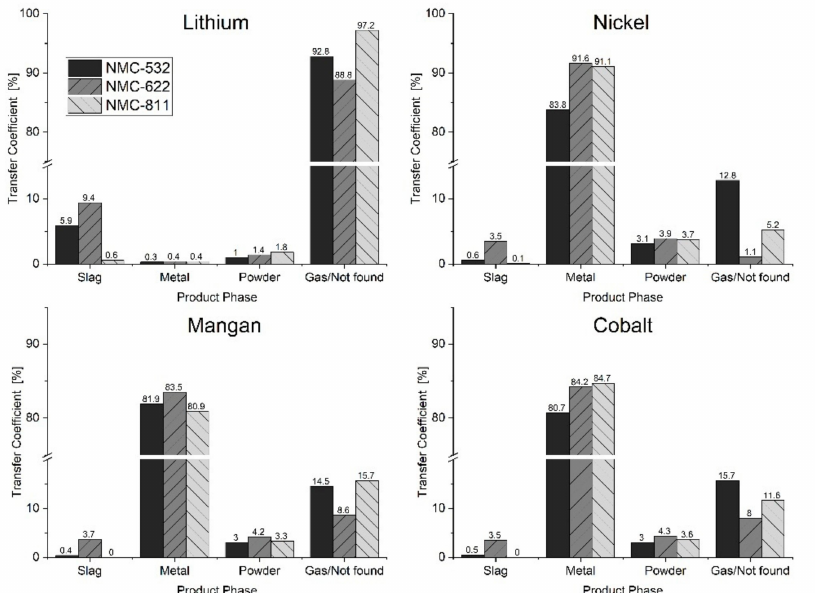
Figure 9. Overview of the transfer coefficients (= percentage of originally charged amount) of Li, Ni, Mn, and Co into the product phases during the InduMelt experiments with NMC532, NMC622, and